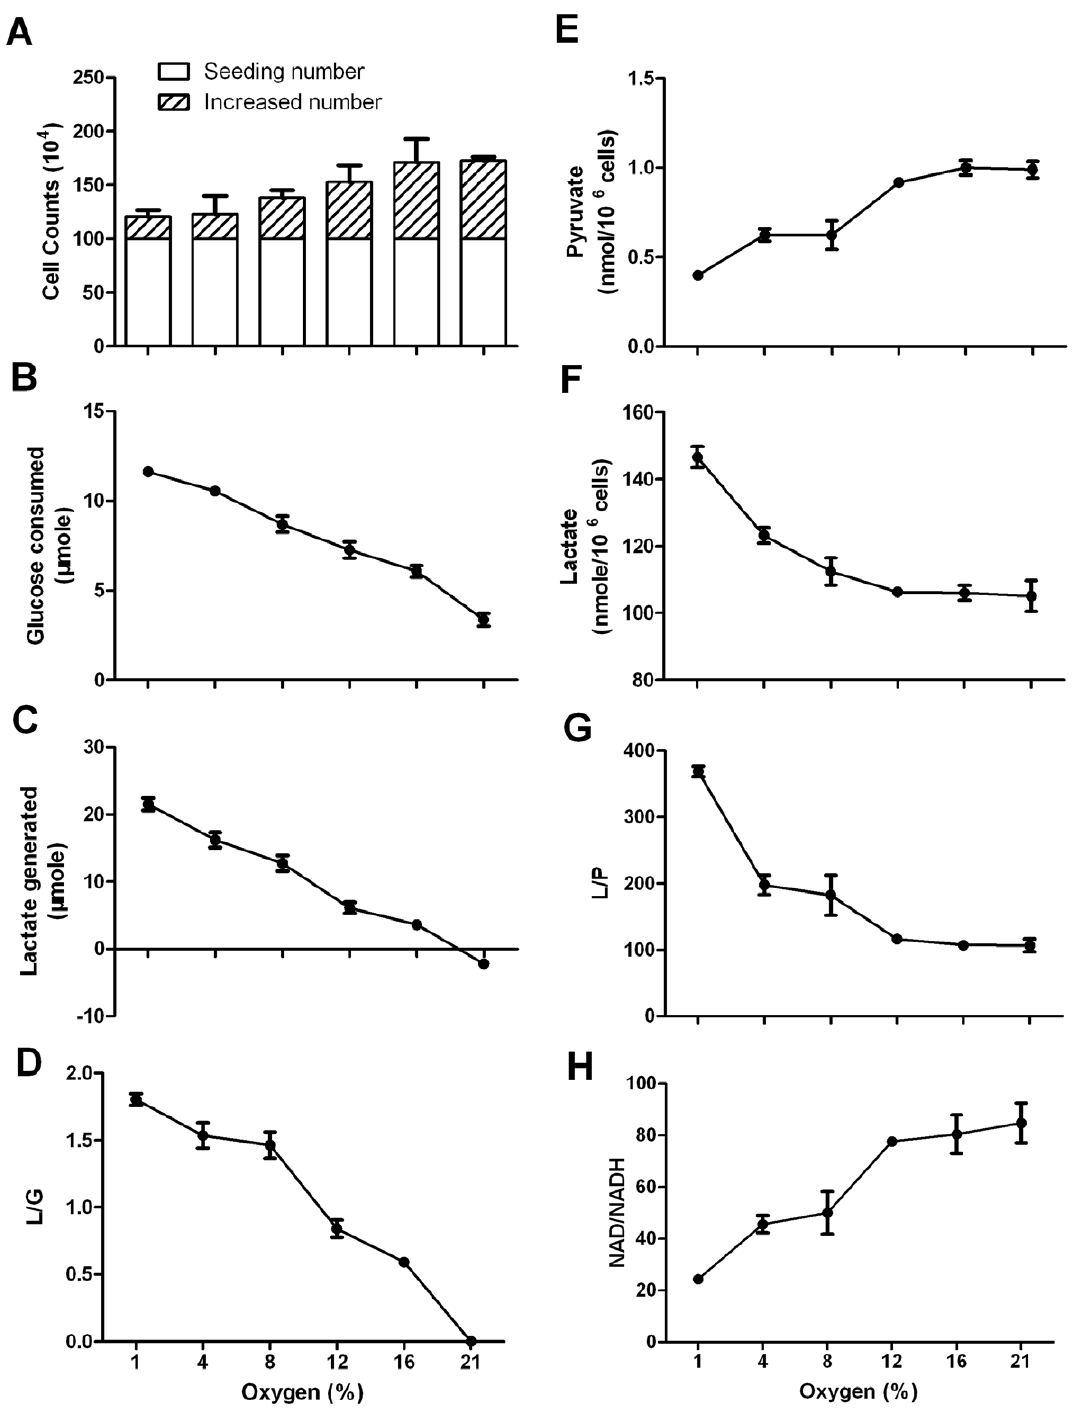
Figure 5. The effect of oxygen levels on cytosolic free NAD/NADH ratios in Hela cells. Hela cells were incubated in complete RPMI-1640 medium containing 12 mM glucose supplemented with 20 mM lactate under oxygen levels between 21% to 1%. After 24-hour incubation, glucose consumption and lactate generation by Hela cells, cell growth, and intracellular lactate and pyruvate were measured. (A) Cell proliferation; (B) Glucose consumption; (C) Lactate generation; (D) L/G ratio; (E) Intracellular pyruvate; (F) Intracellular lactate; (G) Intracellular L/P ratio; (H) Cytosolic free NAD/ NADH ratio estimated from the corresponding L/P ratio (see description in text). Data are mean 6 SD. Data were confirmed by 2 independent experiments.